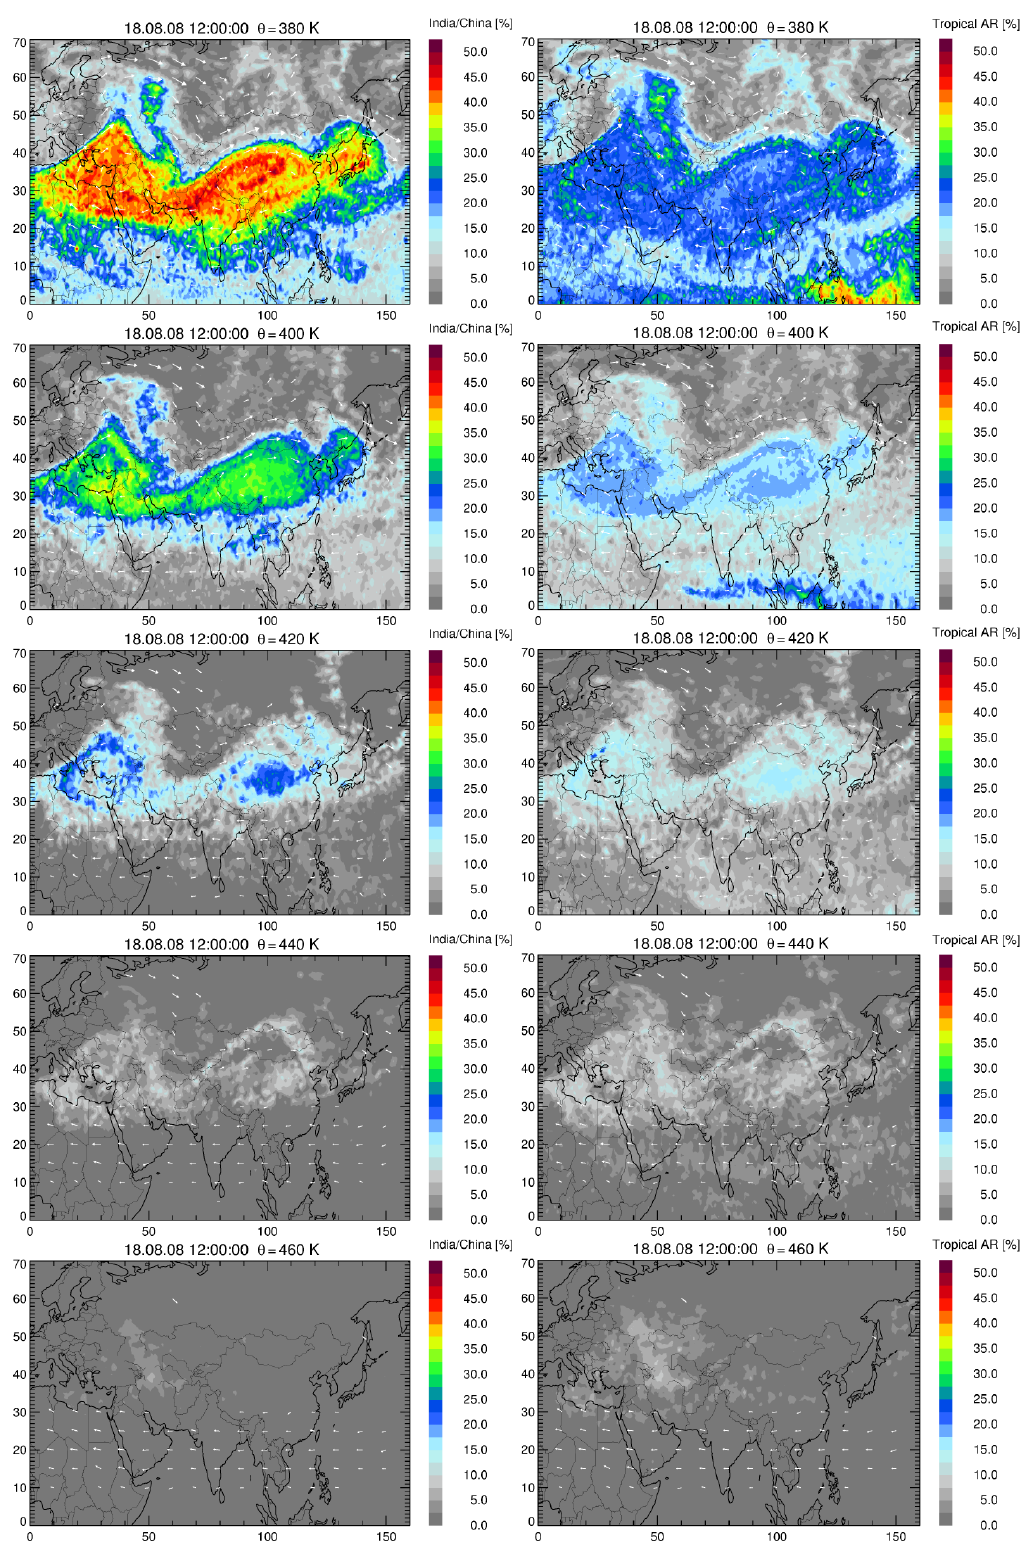
Figure 5. Horizontal distribution of the fraction of air originating in India/China (left) and in tropical adjacent regions (right) at 380, 400, 420, 440, and 460K potential